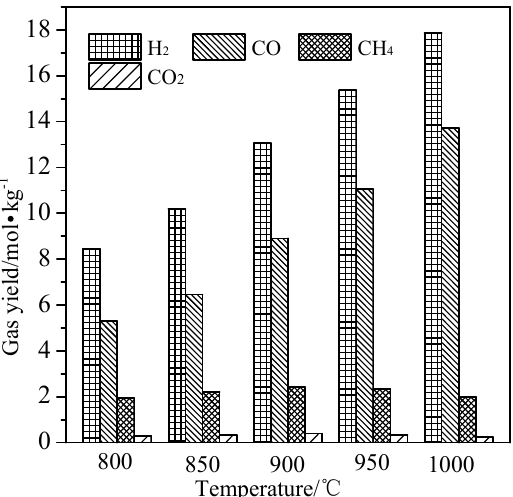
Figure 4. Effect of temperature on the gas yield of lignite gasification.